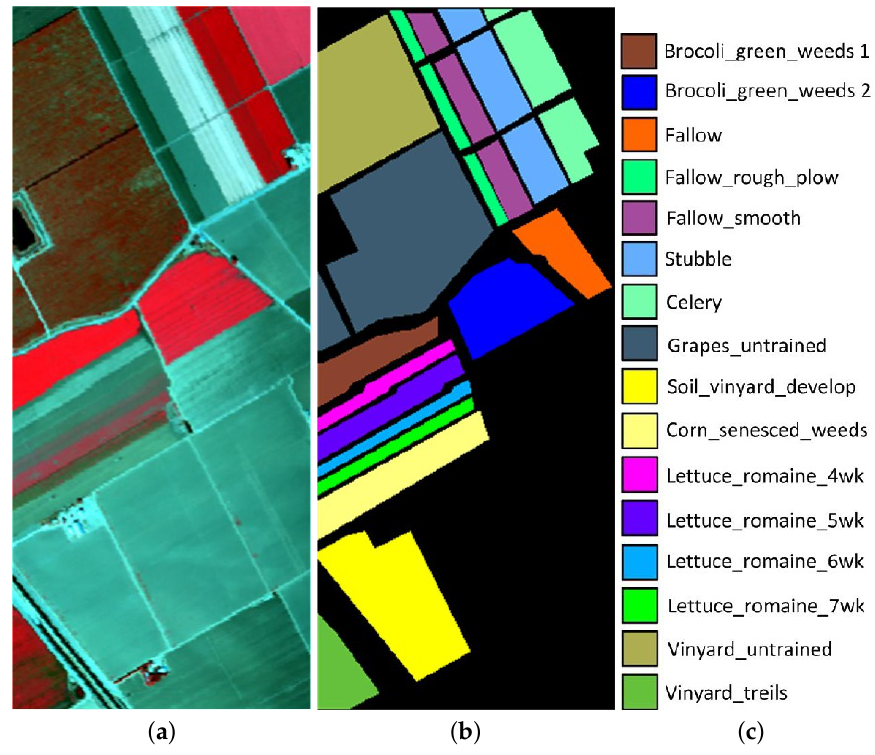
Figure 2. Salinas dataset. ( a ) False color composite. ( b ) Reference image. ( c ) Label name. The Longkou dataset was obtained by an 8-mm focal length Headwall Nano-Hyperspec imaging sensor, over Longkou, Hubei province, China, which was captured by a DJI Ma- trice 600 Pro UAV platform. The flying height of the UAV was 500 m. The spatial size of the dataset contained 550 × 400 pixels, and it consisted of 270 spectral bands ranging from 0.4 to 1 µ m. The spatial resolution of this dataset was about 0.463 m. Figure 3 presents the false-color image and the reference